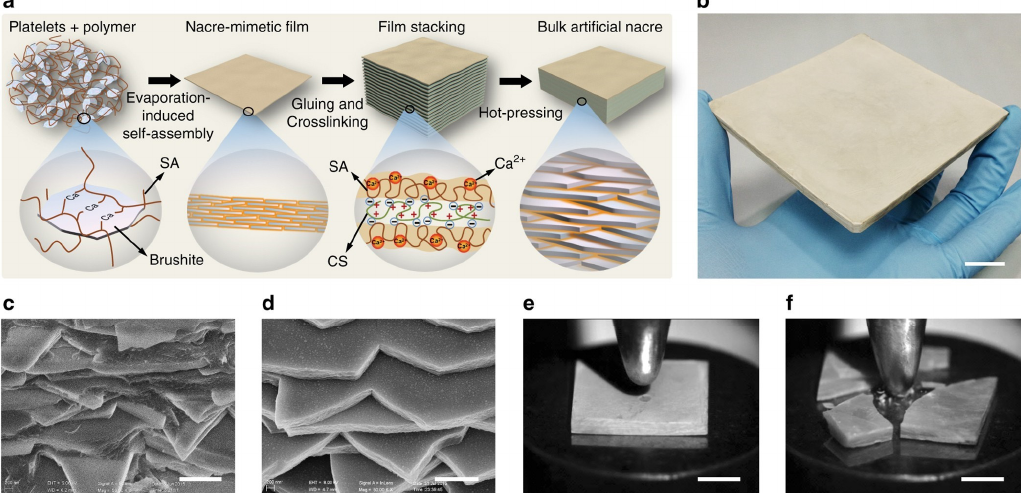
Figure 3. Fabrication and characterization of bulk artificial nacre. ( a ) Schematic illustration of the bottom-up assembly process of bulk artificial nacre. ( b ) Large as-fabricated bulk artificial nacre. Scale bar, 2 cm. Cross-section of the ( c ) artificial nacre and ( d ) natural Cristaria plicata nacre showing a similar fractured layered microstructure. Scale bars, 1 μ m. ( e ) Artificial nacre and ( f ) Cristaria plicata nacre under the same strength of impact, illustrating the higher impact resistance of the artificial nacre. Scale bars, 5 mm. Reproduced from ref. [46] with permission from Springer Nature.